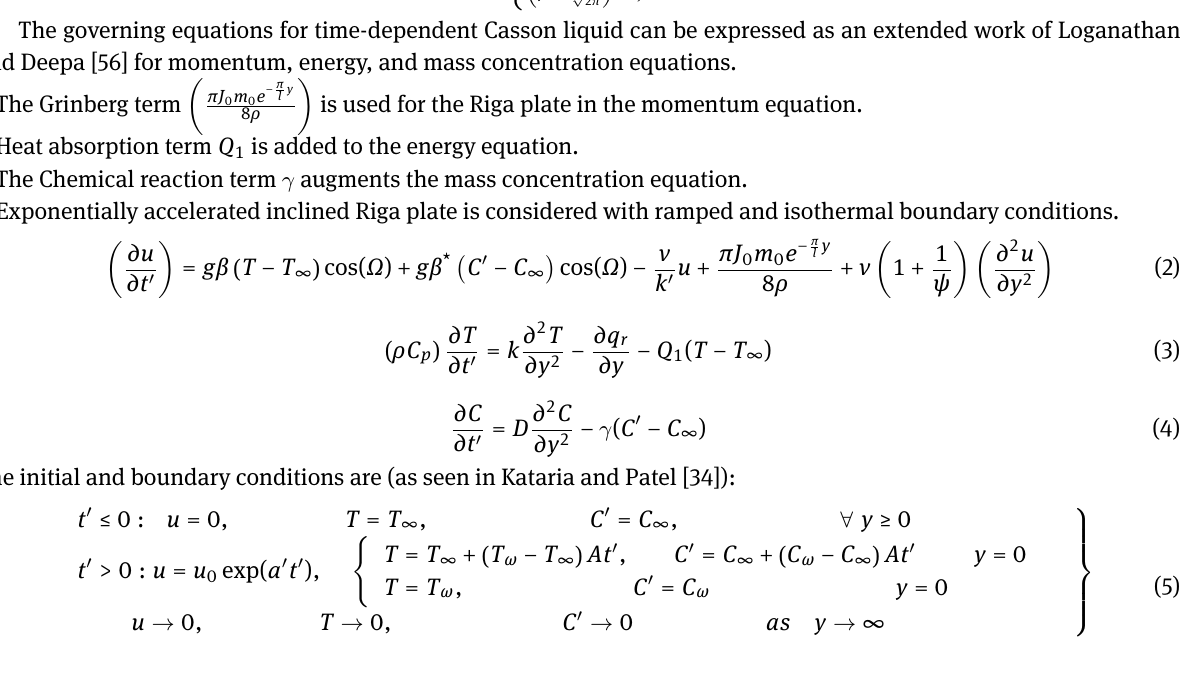
For an incompressible Casson fluid and isotropic flow, the rheological equation of state is as follows: (Khan et al. [41] and Kataria and Patel